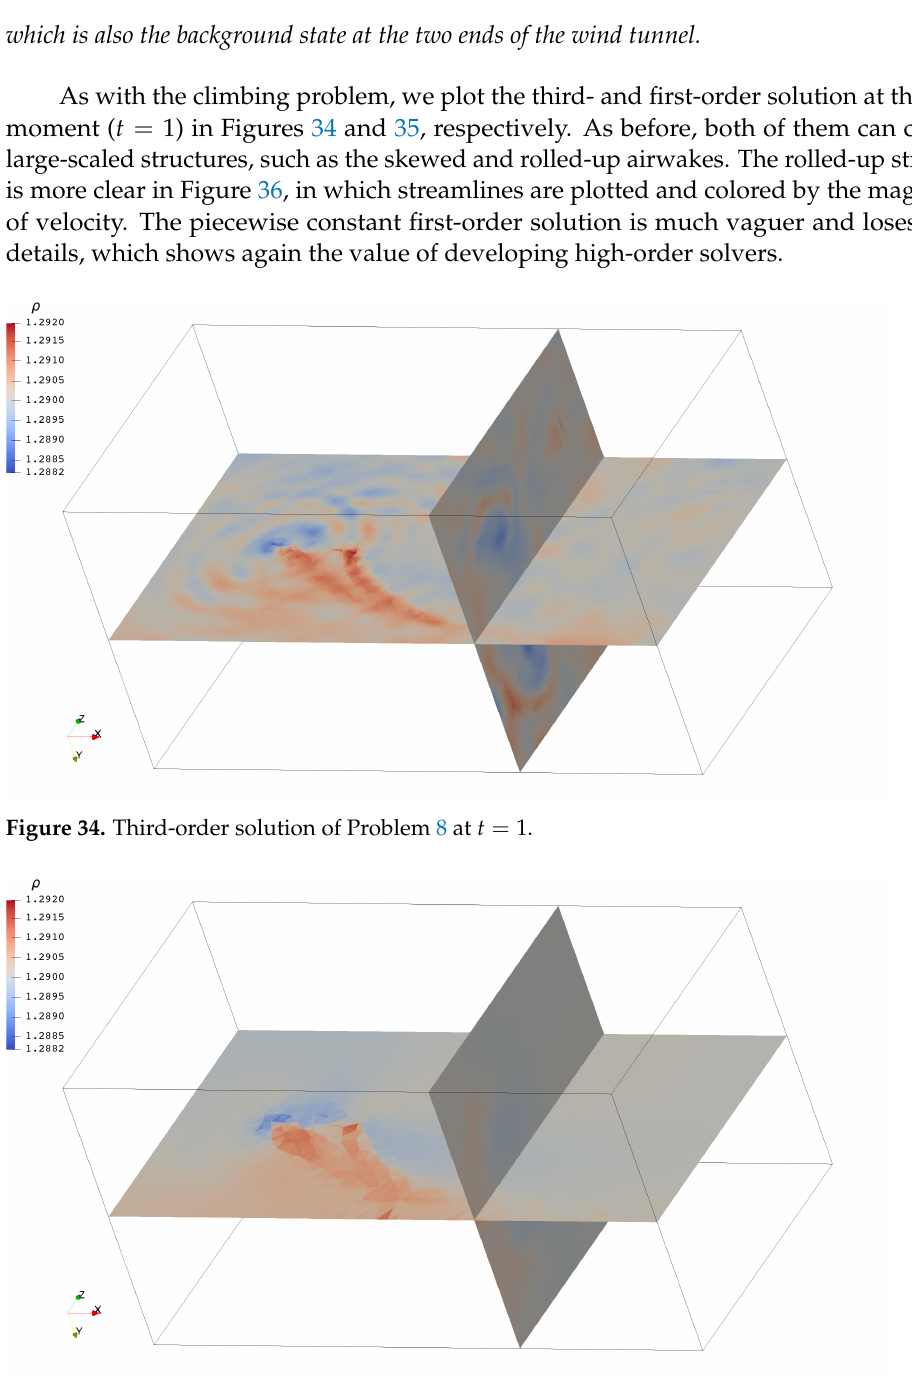
Figure 35. First-order solution of Problem 8 at t =